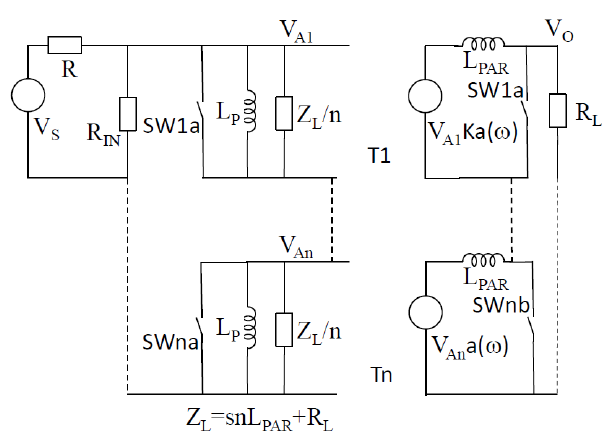
Figure 8. Series connection of n transformers. The value indicated for the impedance Z L is for the case where all n of the switches are open, and the transformers are all operating.